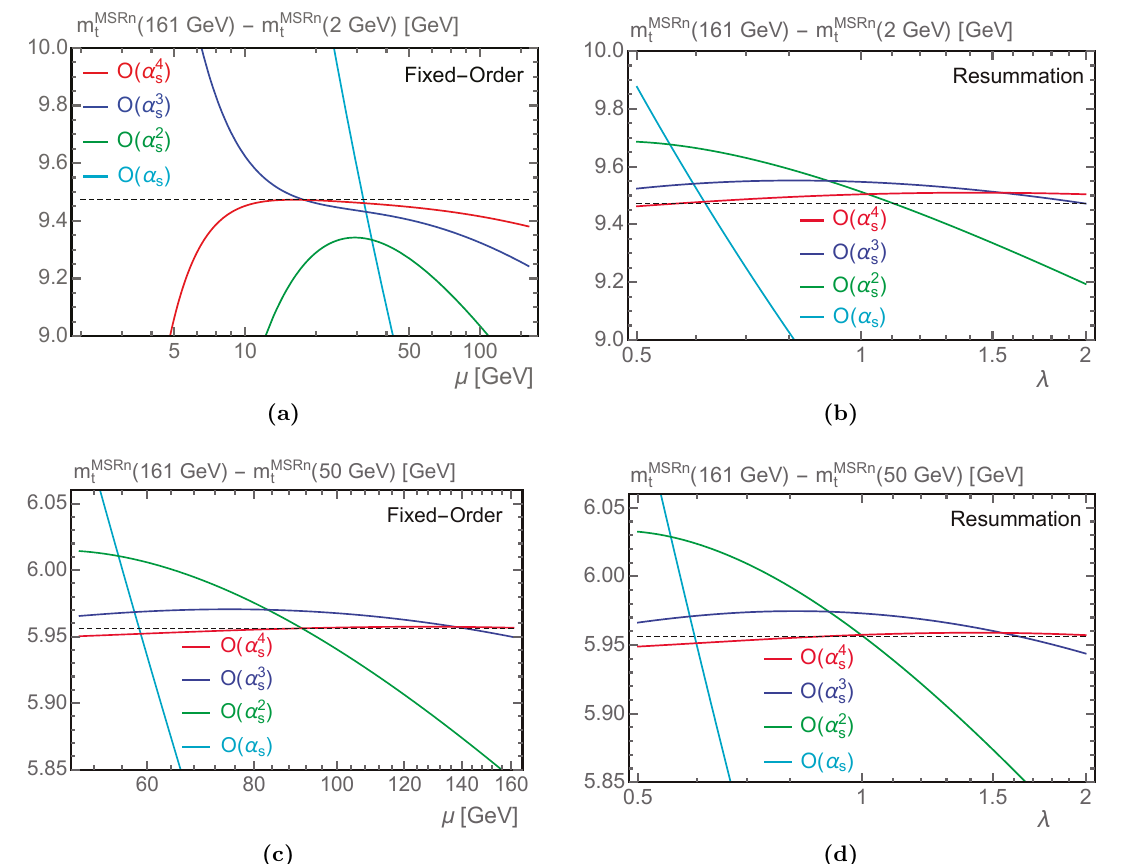
Figure 2. Di(cid:11)erence of the natural top quark MSR mass ( n ‘ = 5) at two di(cid:11)erent scales R including contributions from one to four loops. Results are shown for the di(cid:11)erence between a high scale R 1 = 161 GeV and two lower scales R 2 = 2 GeV (top two panels) and R 2 = 50 GeV (lower two panels). The high and low scales are connected by a (cid:12)xed-order perturbation theory conversion [left two panels, as a function of the scale (cid:22) in (cid:11) s ( (cid:22) )] or via R-evolution [right two panels, as a function of the (cid:21) renormalization